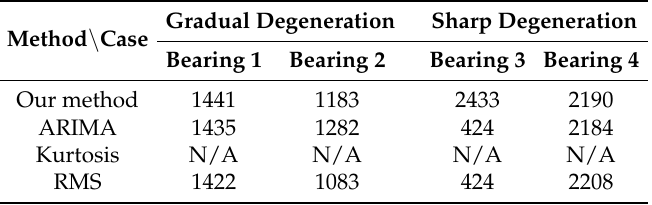
Table 3. Results of bearing early failure